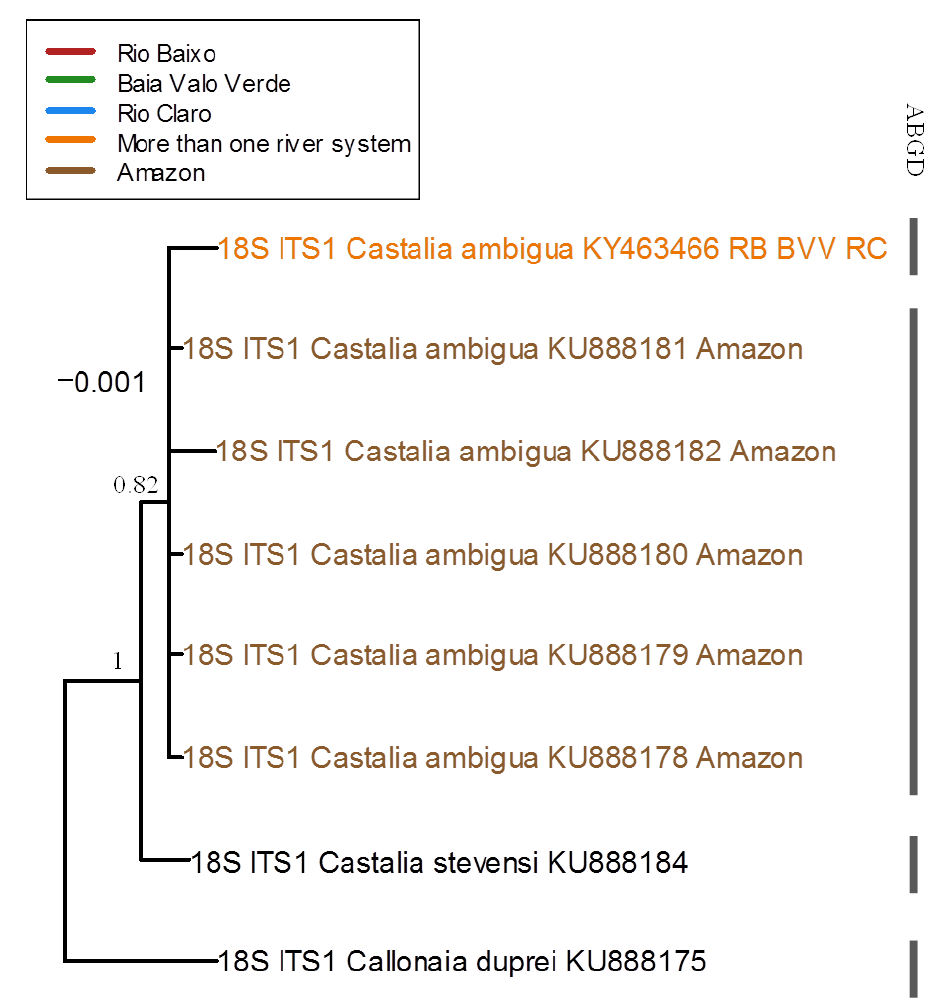
Figure 10. Bayesian phylogenic analysis showing the relationships among our one 18S ITS haplotype sequence (KY463466) and other sequences for Castalia ambigua (KU888178, KU888179, KU888180, KU888182, and KU888181) obtained from Genbank. The outgroups were Castalia stevensi (KU888184) and Callonaia duprei (KU888175). The alignment of these sequences resulted in 515bp sequences. The analysis was run for 500,000 generations to create a set of trees, of which 2178 were sampled. The Bayesian phylogenetic consensus tree had a final average standard deviation of split frequencies of 0.005394 and with a − ln likelihood of − 846.10. Branch lengths are proportional to inferred evolutionary distances. Numerals to the left of nodes indicate posterior probability support for the respective nodes. The distance bar is shown in units of substitutions per nucleotide site. ABGD on the right margin refers to species delimitations suggested by Automatic Barcode Gap Discovery [57].